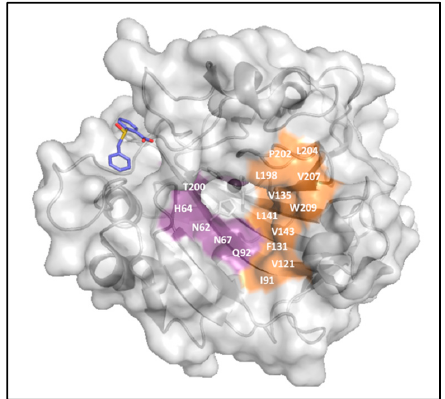
Figure 7. The 2-[( S )-benzylsulfinyl] benzoic acid ( periwinkle ) in complex with CA ΙΙ ( gray ) (PDB:4QY3)